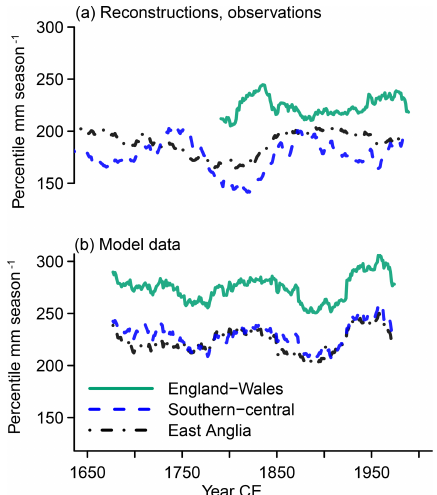
Figure 5. Visualization of the MAMJJ precipitation amount iden- tified as severely dry (percentile 6.7) over 51-year windows for England–Wales (green solid lines), southern–central England (blue dashed lines), and East Anglia (black dash-dotted lines) in (a) re- constructions, observations, and (b) simulations.